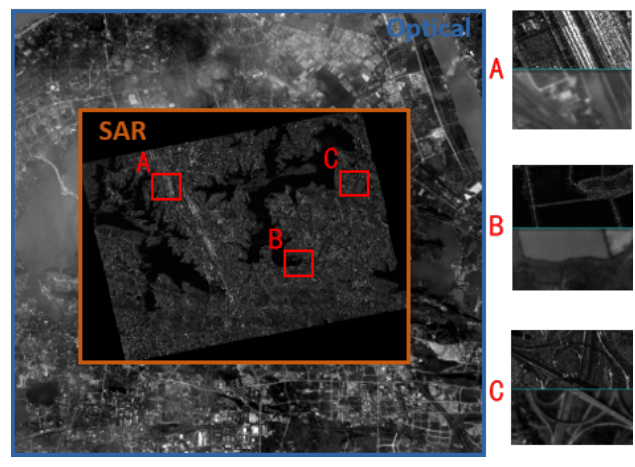
Figure 14. The pair D. Table 2. Detailed description of test data for the experiment of the